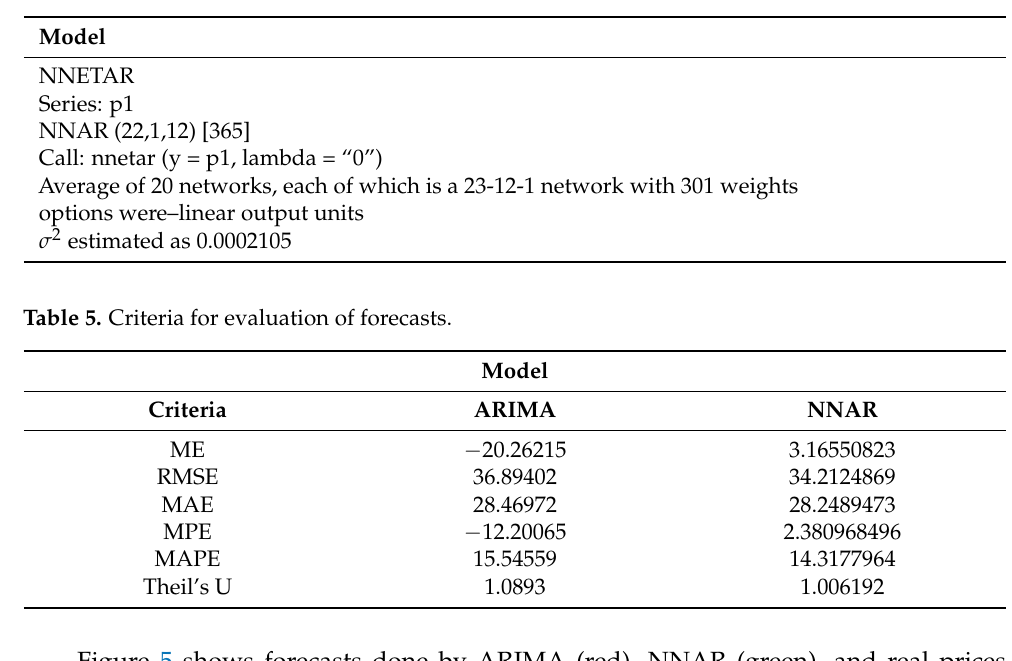
Table 4. Estimated NNAR model.